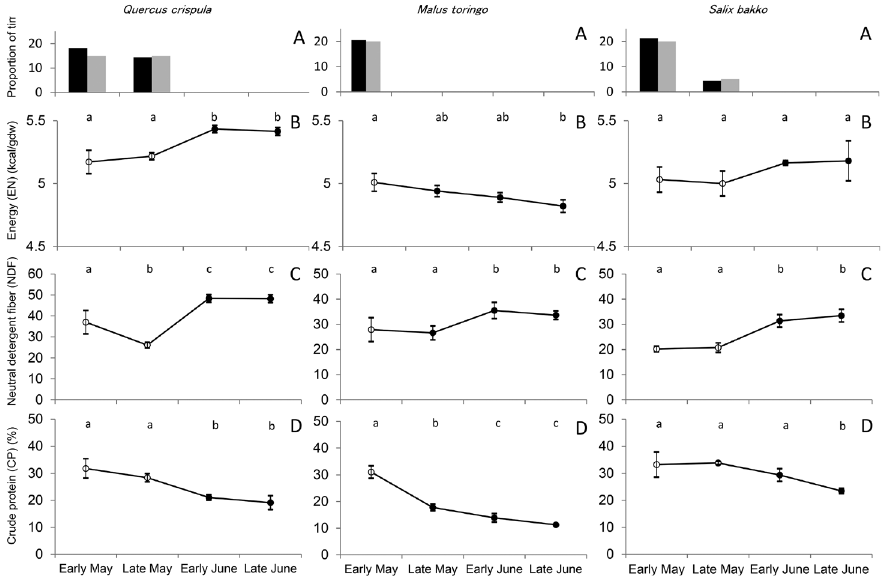
Figure 2. Proportion of observed time for each food item and seasonal changes in the nutritional values of Quercus crispula (left) leaves, Malus toringo (center) leaves, and Salix bakko (right) leaves from early May (leaf flash) to late June 2013. A The proportion of time for which bears were observed consuming (2013: black and 2014: gray) B total energy C neutral detergent fiber, and D crude protein. Different lower case letters within each graph indicate significant differences (Kruskal–Wallis test, P < 0.05). White circles in- dicate when bears were observed consuming Q. crispula leaves (early May and late May), M. toringo leaves (early May), and S. bakko (early May and late